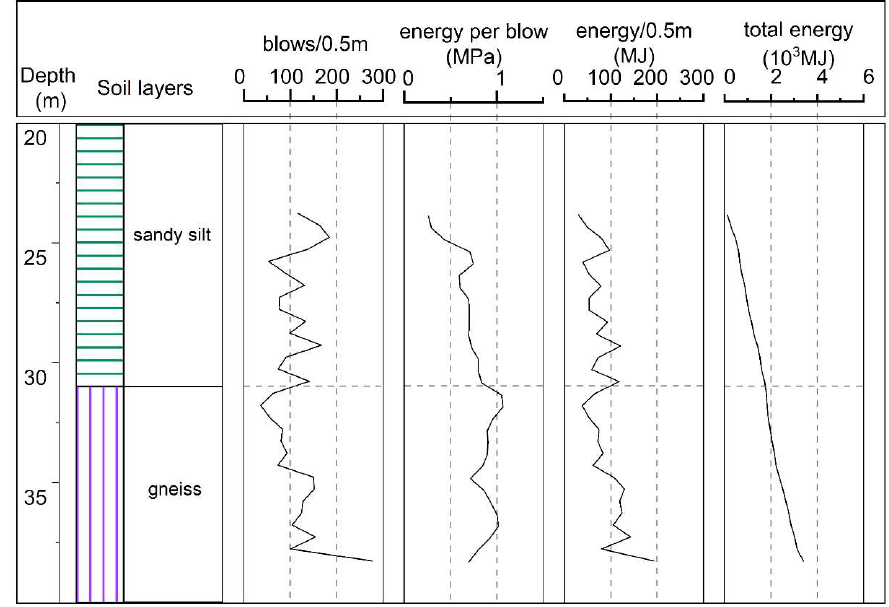
Figure 4. Pile B1 driving records.